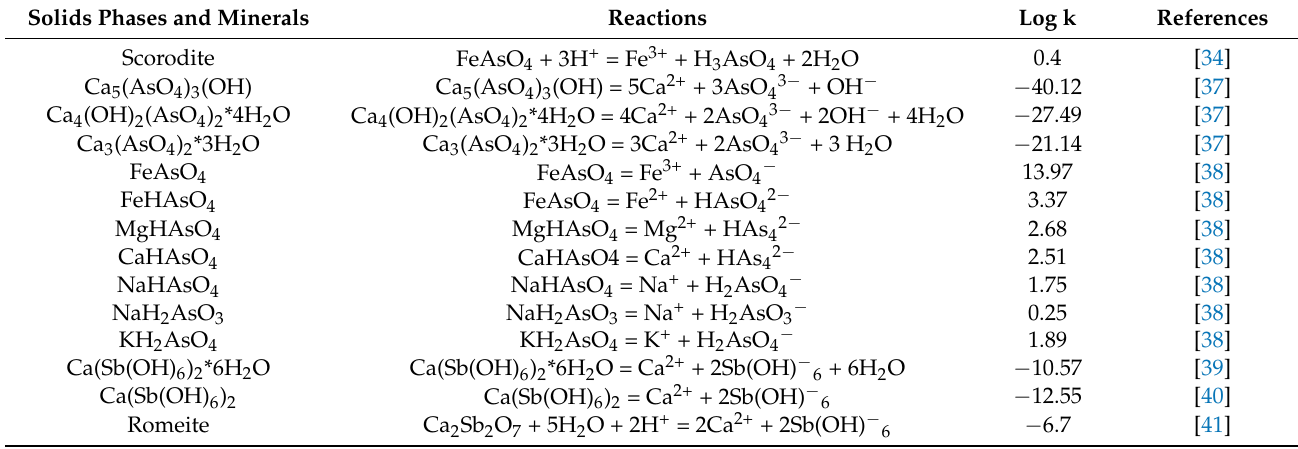
Table 2. Thermodynamic properties included in the minteq.v4 database. The solids phases or minerals, the precipita- tion/dissolution reactions, the Log k and the corresponding reference(s) are